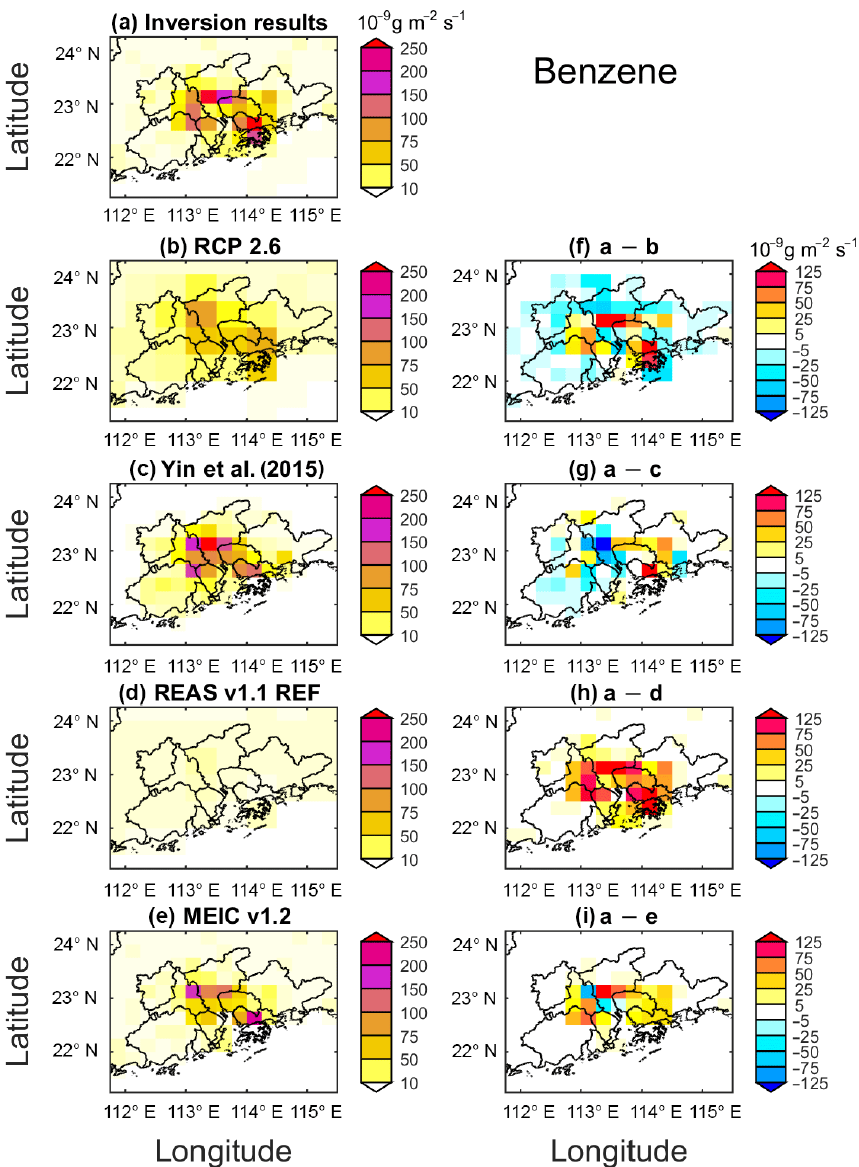
Figure 6. Maps of benzene emissions for the PRD, HK, and surrounding regions from (a) inversion, (b) RCP2.6, (c) Yin et al. (2015), (d) REAS v1.1 REF, (e) MEIC v1.2, and the difference between inversion results (a) and the bottom-up inventories (b, c, d, e) . Note that in (c) and (g) only emissions within the PRD are plotted since Yin et al. (2015) only estimated emissions within PRD, and that in (e) and (i) emissions within HK are not plotted since MEIC v1.2 has not estimated benzene emissions in